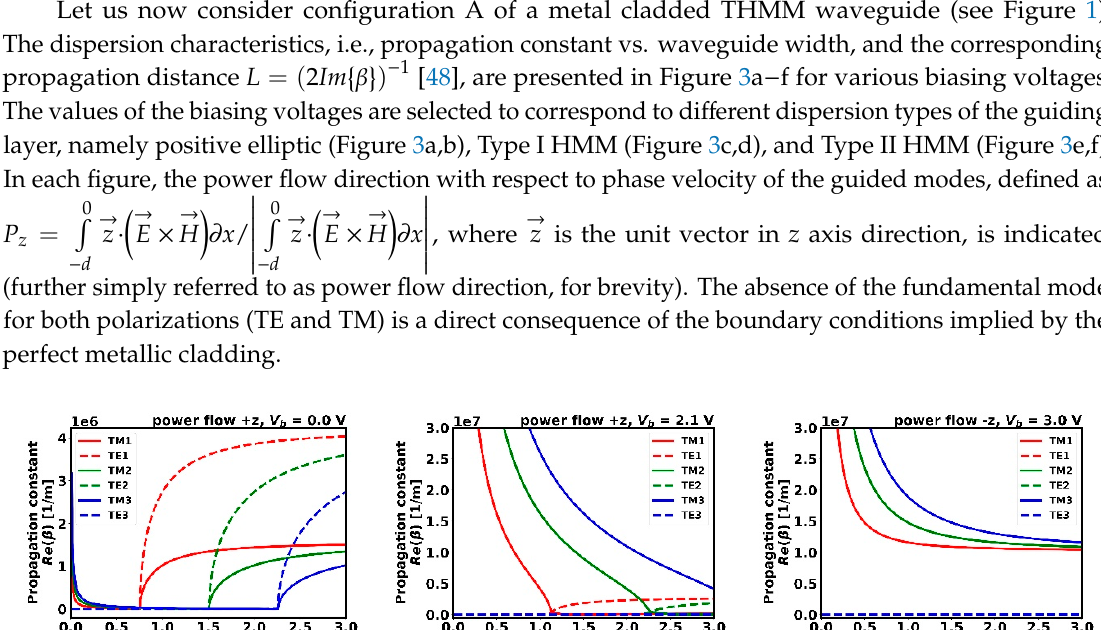
6 of 13 Figure 2. Effective permittivity tensor components of the guiding medium at 1.55 µm dependent on the voltage bias V b applied. Three dispersion regions are indicated: positive elliptic (0 < V b < 1.98 V),